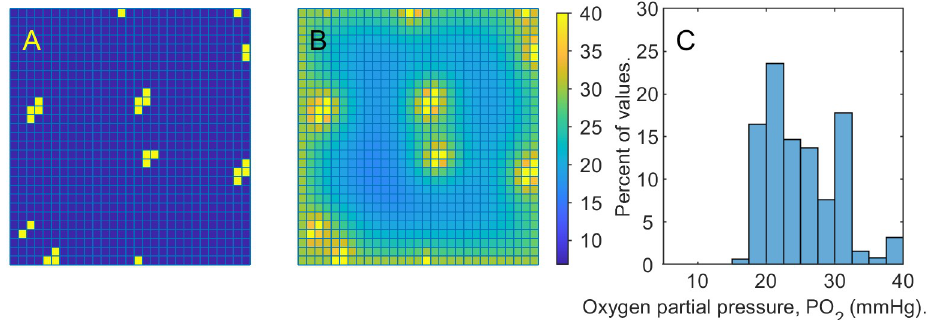
Fig 5. Oxygenated tissue. A: yellow squares mark the presence of capillary sources. B: oxygenation levels of the domain with the capillary sources as in the picture on the left and no damaged cells. Lower values of PO 2 correspond to darker blue. As PO 2 increases, the color in the picture turns yellow. The most bright yellow squares can be identified with capillary positions. C: PO 2 histogram corresponding to the tissue sample for the oxygenation map depicted in the